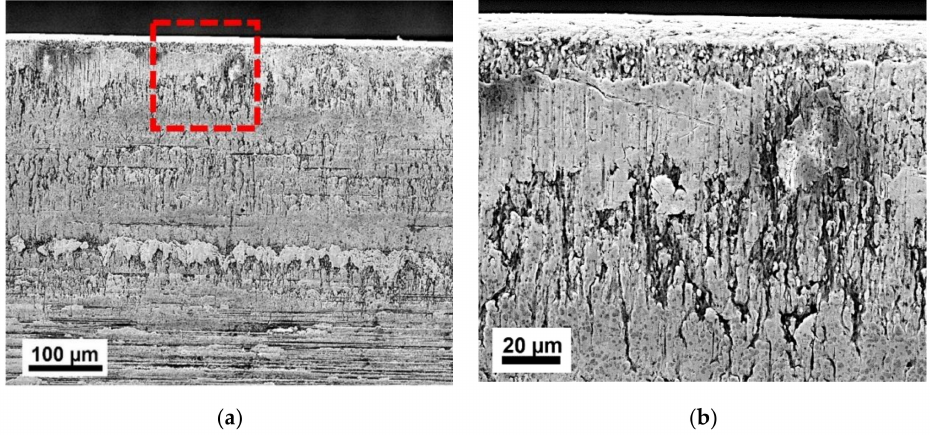
Figure 12. ( a ) Worn surface of the VSC punch and ( b ) a higher magnification of the cutting